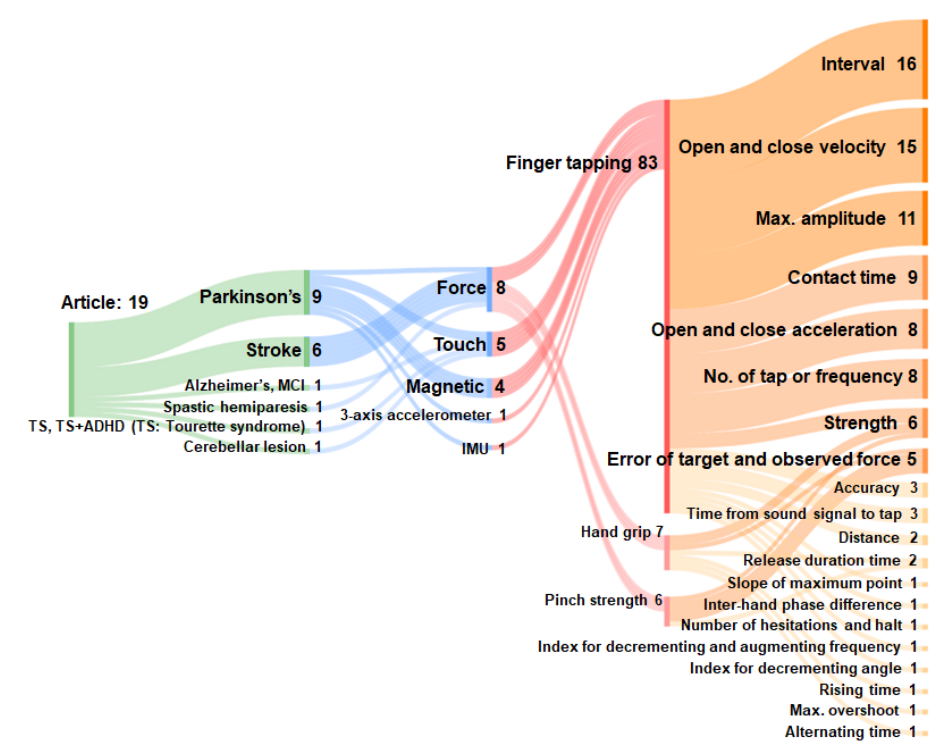
Figure 3. Sankey diagram of hand function measurement method for each type of brain disease